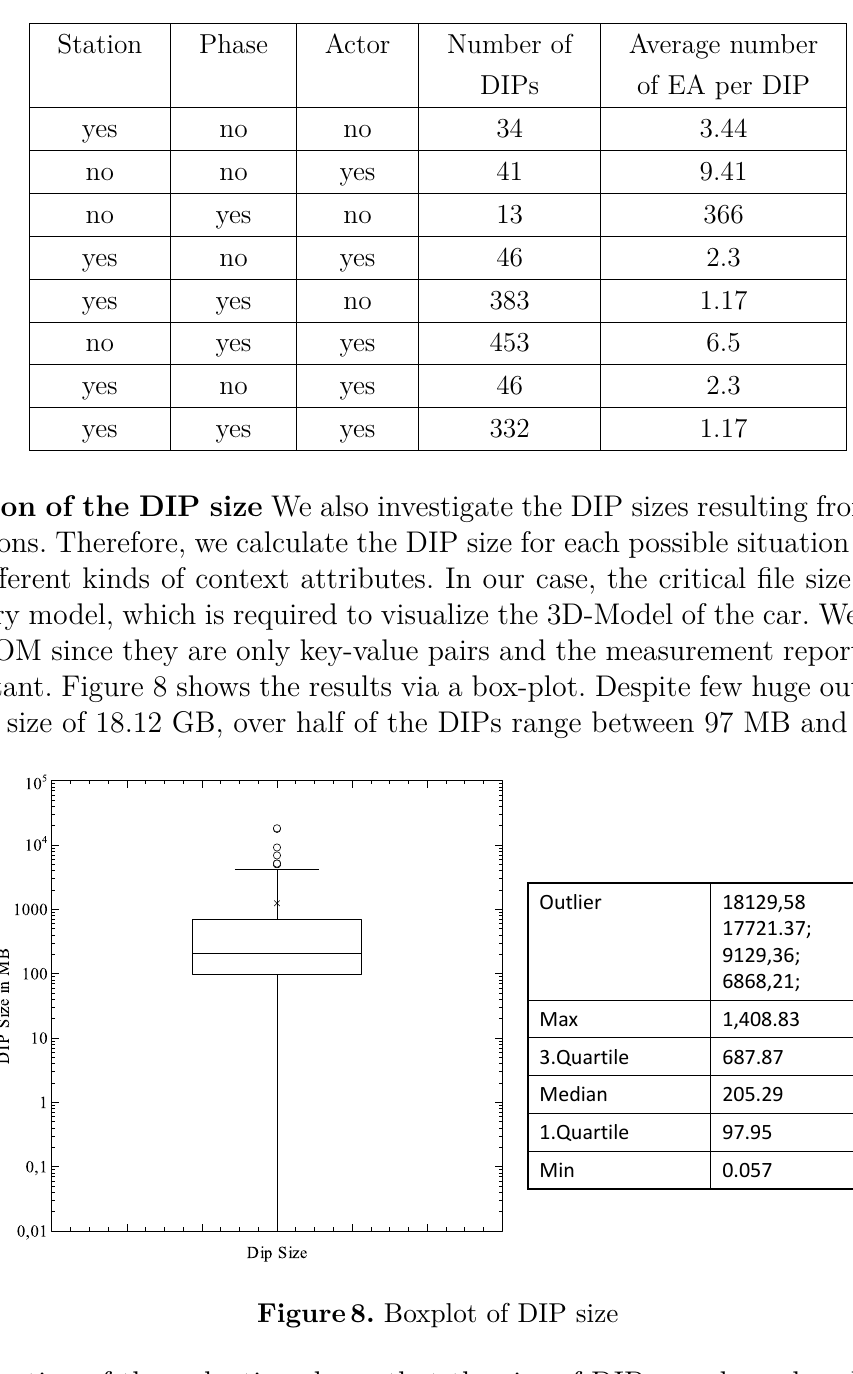
Table 2. Reduction of engineering artifacts